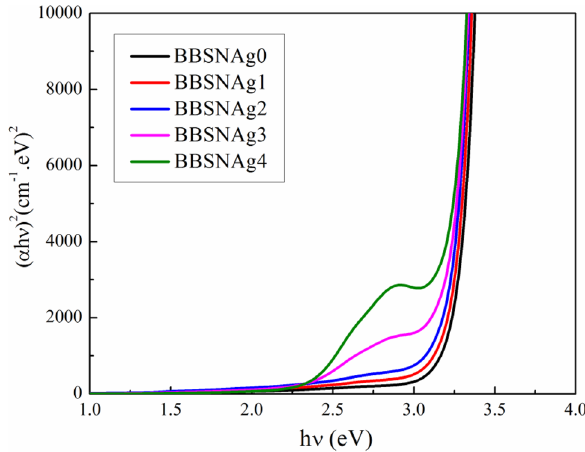
Figure 4. The dependence of (αhν) 2 on (hν) for direct transitions for examined glass.